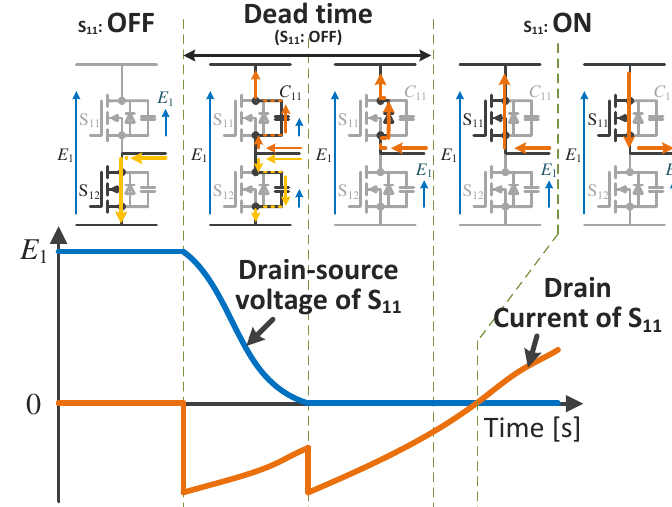
Figure 4. Transition diagram of the operation mode focusing on turning S 11 on with soft